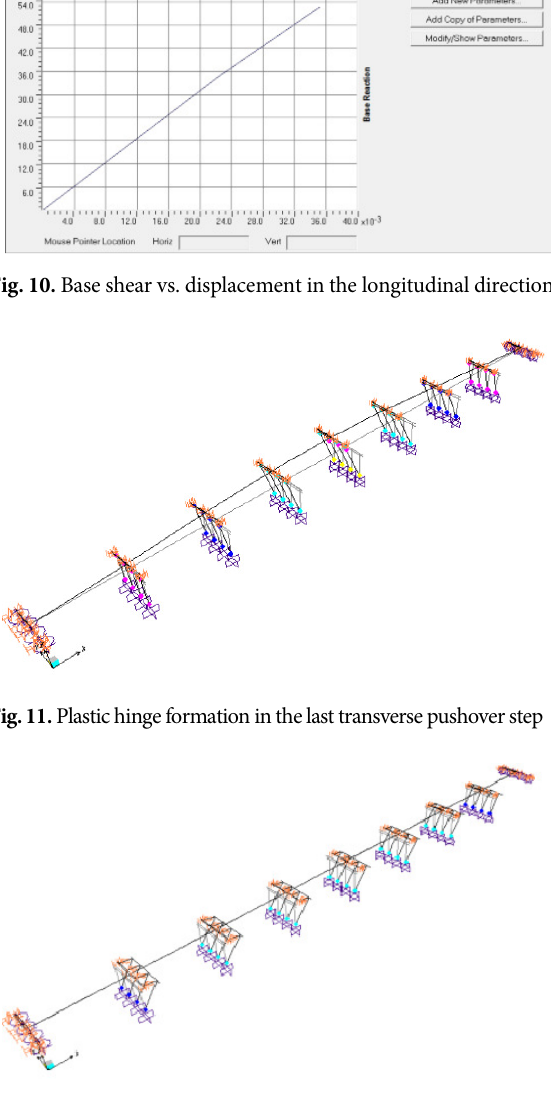
Fig. 12. Plastic hinge formation in the last longitudinal pushover